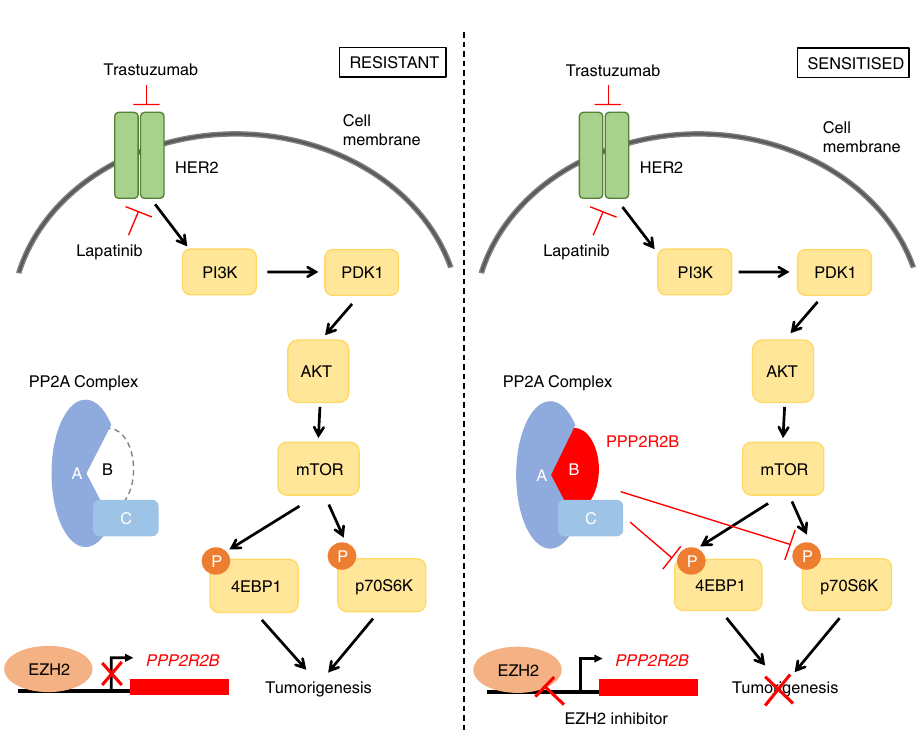
Fig. 9 Proposed model for the role of PPP2R2B in determining the sensitivity to HER2-targeted therapies. EZH2-mediated repression (left) of PPP2R2B leads to the absence of functional PPP2R2B-containing PP2A, and thus residual p-4EBP1 and p-p70S6K and tumorigenesis, with HER2-targeted therapies. Accordingly, inhibition of EZH2 (right) restores PPP2R2B expression and functional PPP2R2B-containing PP2A that reduces phosphorylation of 4EBP1 and p70S6K and thus inhibits tumorigenesis under anti-HER2